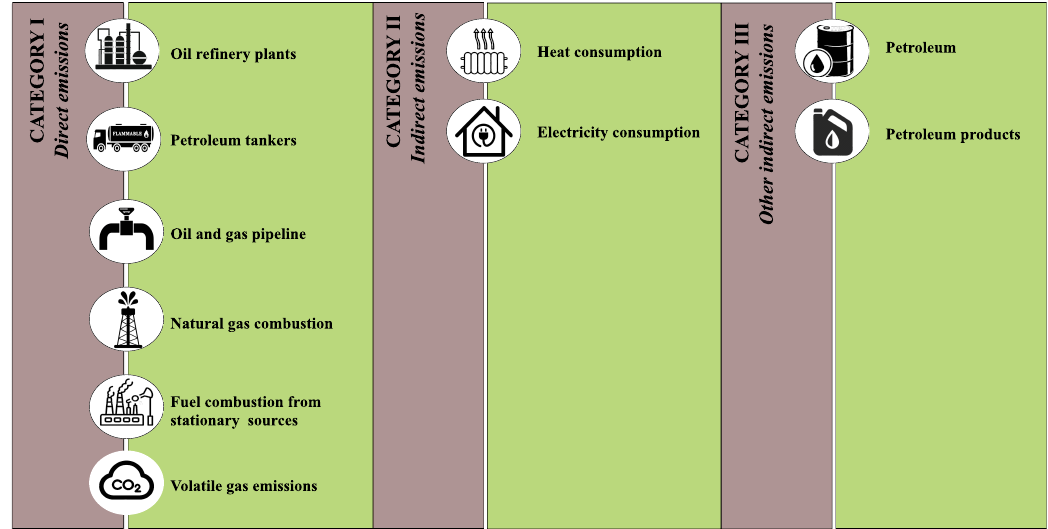
Figure 3. Categories of emissions from oil